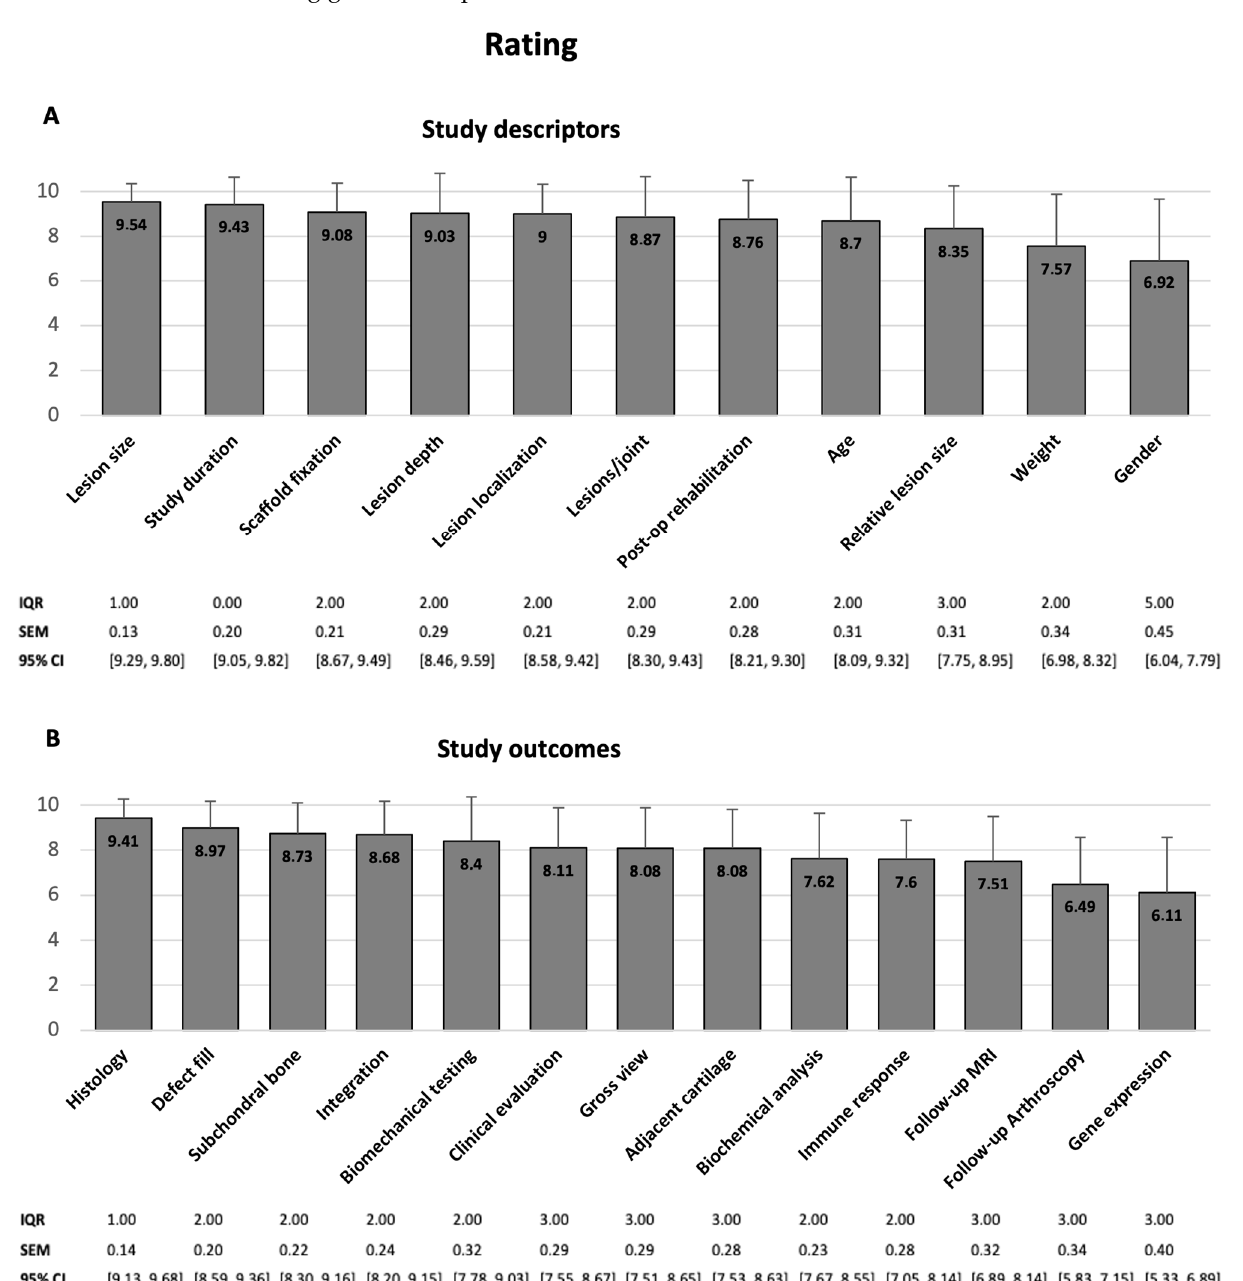
Figure 3. Illustration of the survey ratings for every single guideline aspect regarding to their individual importance in the design of pivotal animal trials. ( A ) study descriptors and ( B ) study outcomes, arranged according to decreasing importance. Whiskers represent standard deviations. n = 37 (participants); 10= most important; IQR interquartile range; SEM standard error of the mean; CI confidence interval.